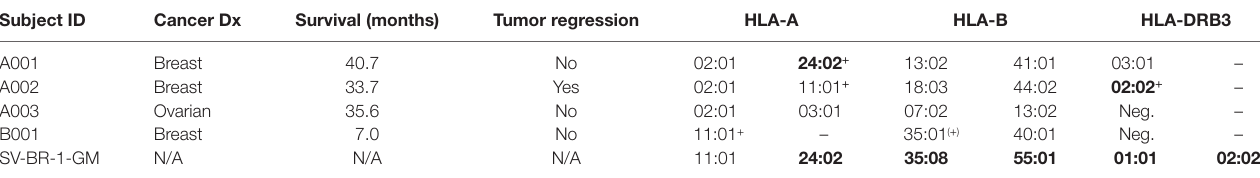
TaBle 2 | HLA alleles.